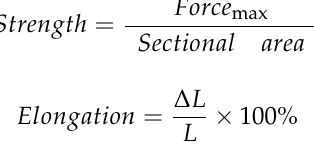
Figure 4. The shape and dimension of samples for tensile test.